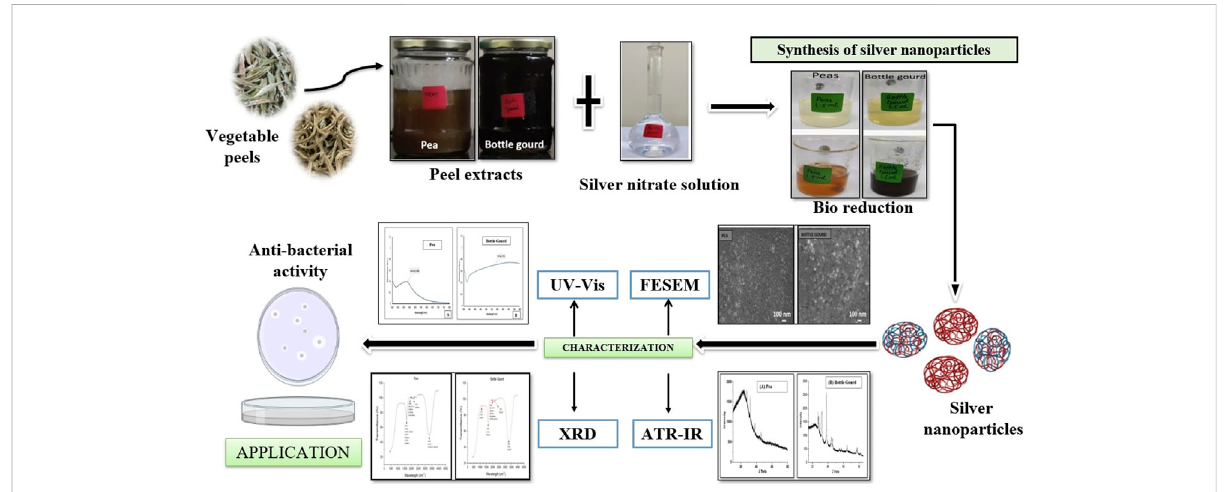
FIGURE 1 Graphical representation about the synthesis of silver nanoparticles, characterization and its antibacterial activity from the peels of pea ( Pisum sativum) and bottle gourd ( Lagenaria siceraria) .